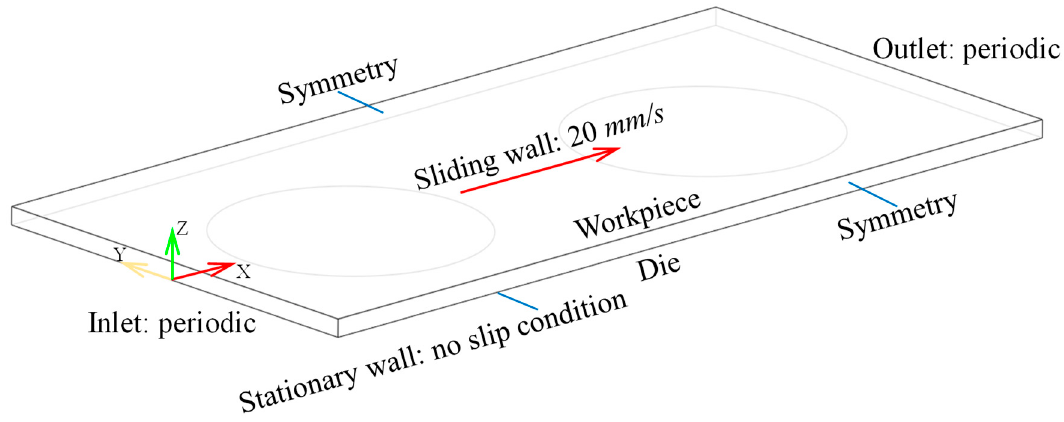
Figure 7. Fluid domain and boundary conditions of a two parallel contacting couple between the die and the workpiece with thin-film lubrication.